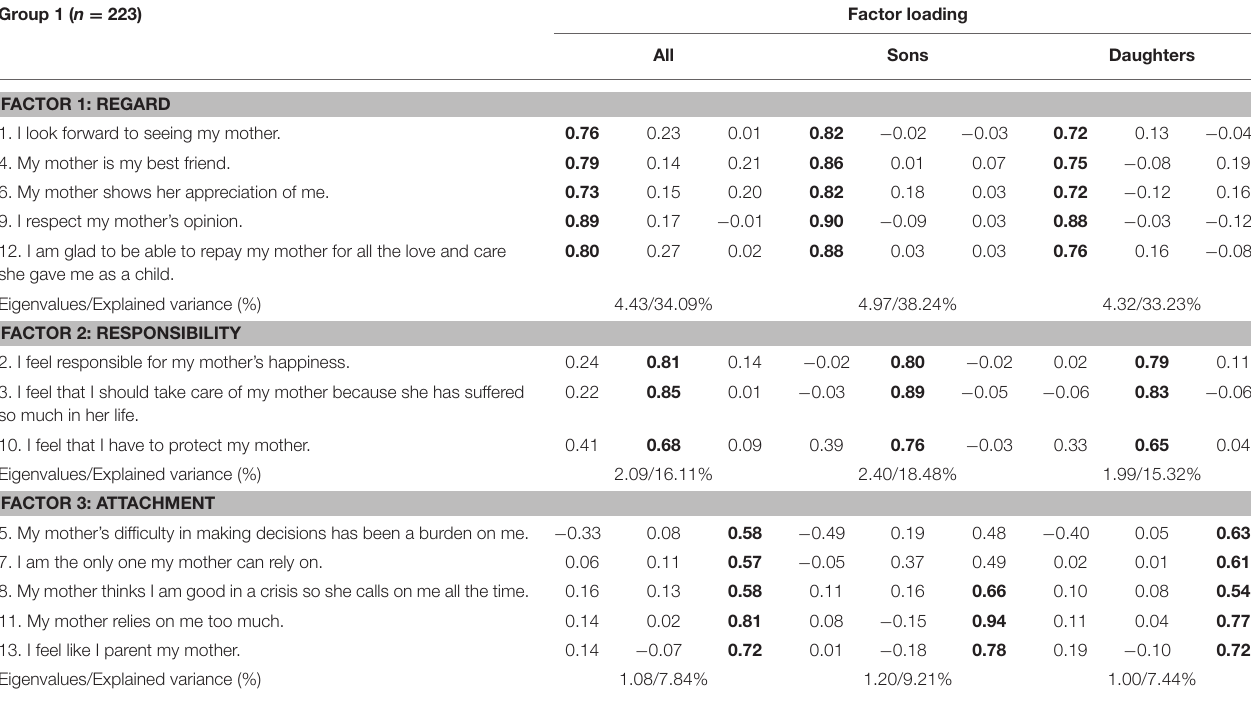
TABLE 4 | Principal Factor analysis of the PACQ for mother.